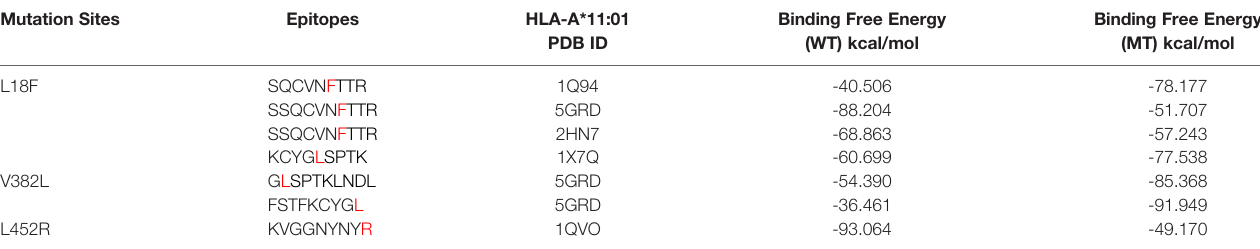
TABLE 3 | Results of binding free energy after MD simulation with HLA-A*11:01 and selected epitopes. Mutation